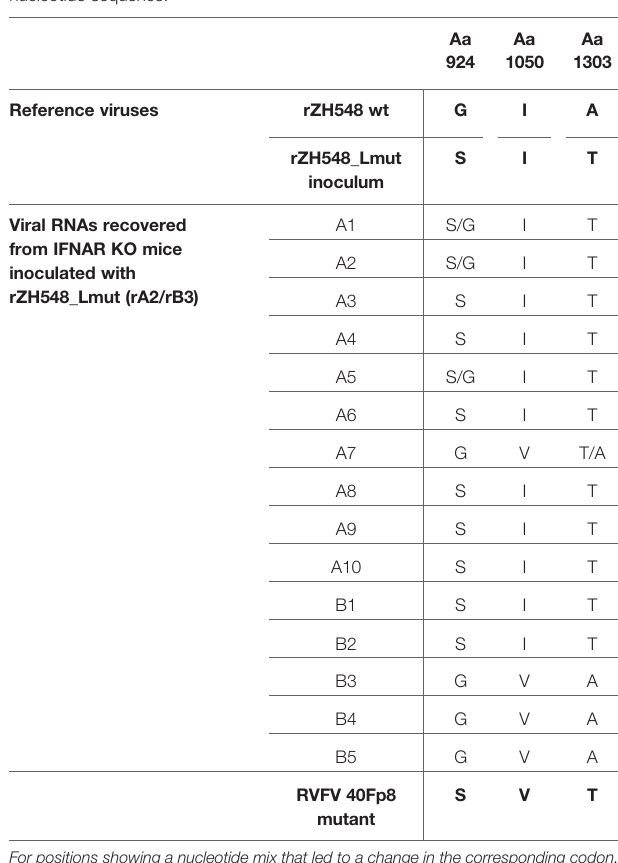
TABLE 4 | Amino acid (one-letter code) found in the three positions of the L- protein under study (924, 1050 and 1303) as deduced from the corresponding nucleotide